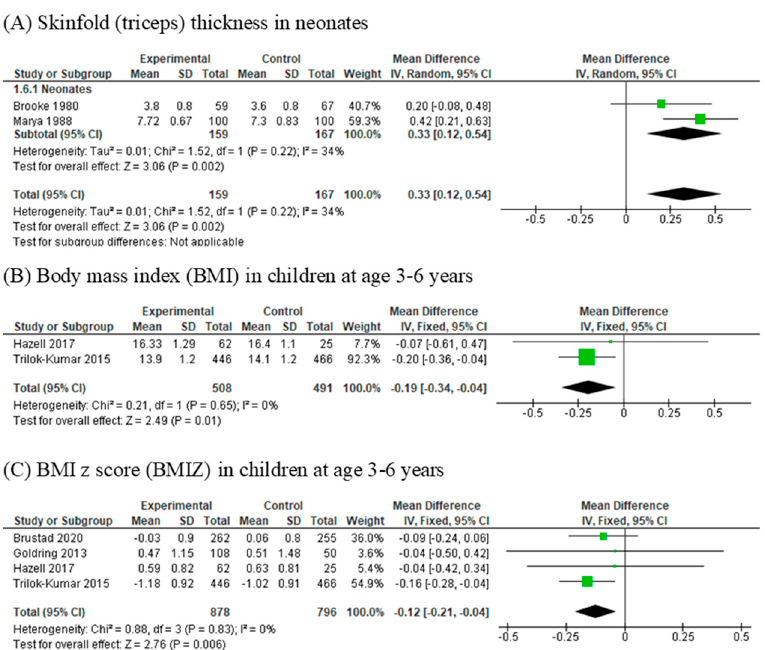
Figure 3. Forest plots of summary crude risk ratios of the association between vitamin D supplementation in early life and adiposity indicators (( A ) Skinfold thickness, mm; ( B ) Body mass index; ( C ) Body mass index z score) in